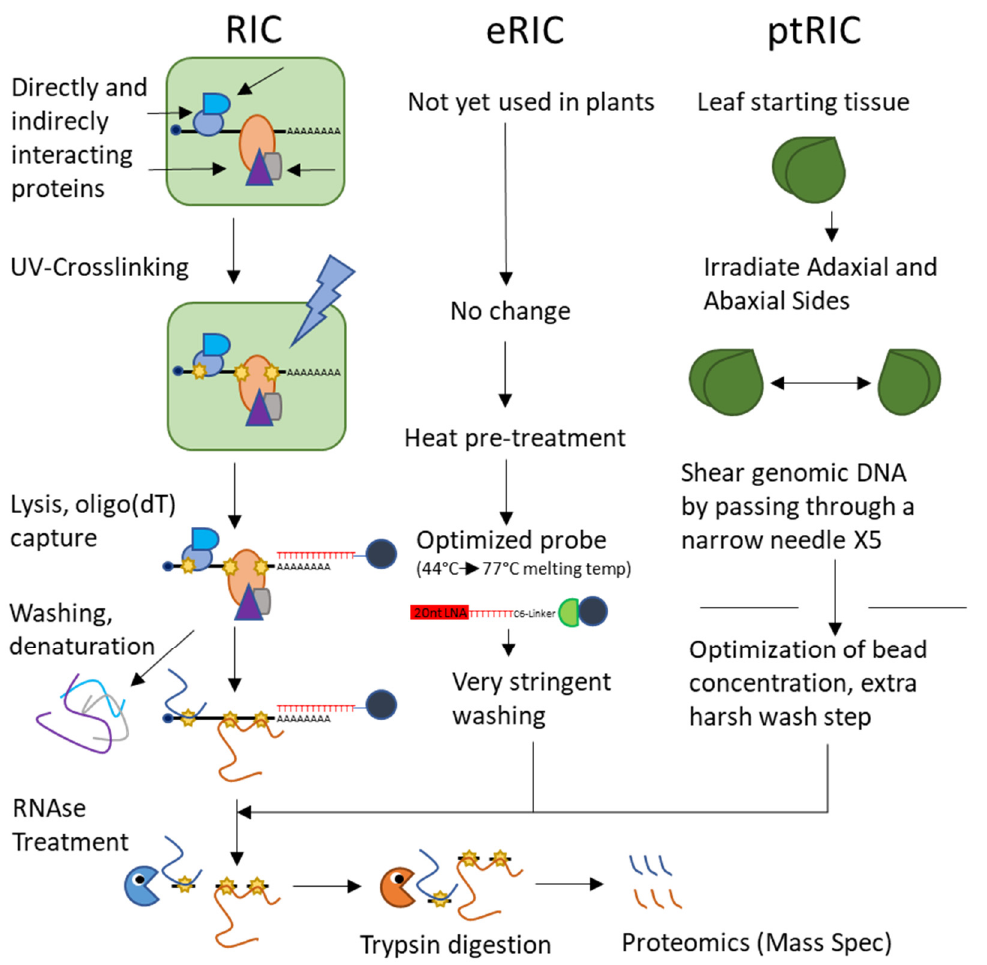
Figure 3. RNA Interactome Approaches for RBPome Investigation. The basic RNA interactome approach involves UV-crosslinking (either traditional or using photoactivatable nucleoside 4SU) to covalently bond RNA to interacting proteins, cell lysis, pulldown of polyA RNA using oligo(dT) conjugated beads, followed by stringent washing, denaturation of proteins to eliminate non-crosslinked interactions, and then RNAse treatment to remove RNA, trypsin digestion, and mass spectrometry proteomics to identify the crosslinked protein cohort. Enhanced RIC (eRIC, not yet used in plants) uses a heat pre-treatment to dissociate non-crosslinked proteins and an optimized DNA probe conjugated to beads instead of standard oligo(dT) beads. The optimized probe permits very stringent washing conditions, which eliminates background. ptRIC was developed specifically for plants and optimizes irradiation conditions by repeatedly irradiating both sides of the leaves, removing genomic DNA by shearing, and optimizing bead concentration. There is no apparent barrier to combining the eRIC and ptRIC approaches to generate a super-optimized RIC protocol for plants.